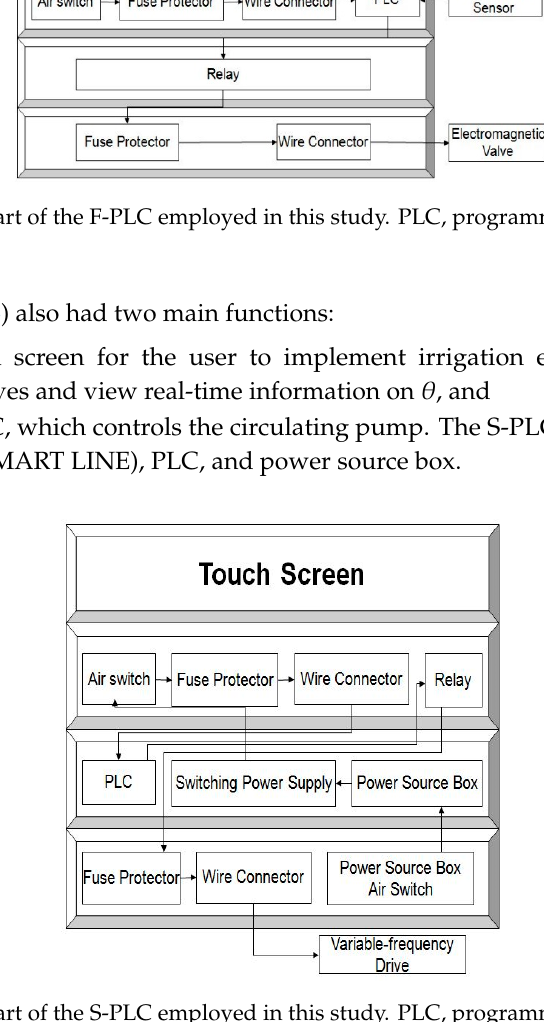
Figure 5. Design chart of the F-PLC employed in this study. PLC, programmable logic controller.